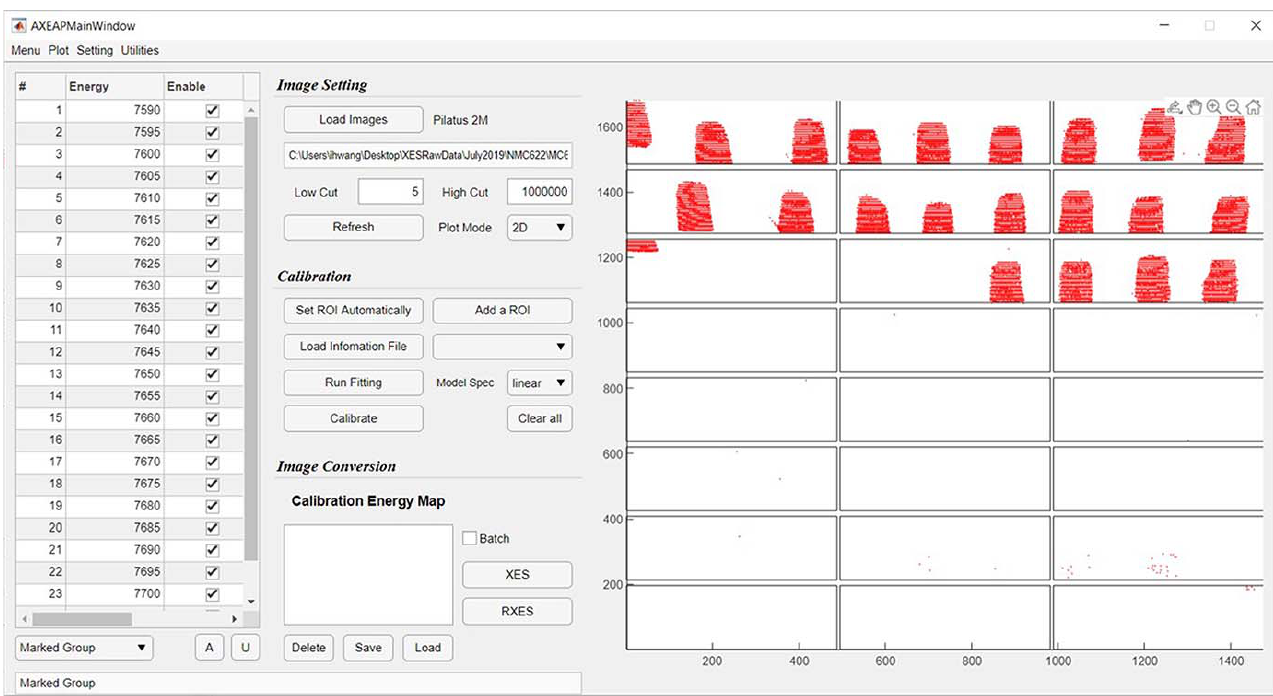
Figure 2 A screenshot of the main window of AXEAP. The graphic part on the right-hand side shows the distribution of the X-ray hit positions as red dots and is divided into 24 areas due to the specification of the detector used for measurement. The signal shown in the graphic part represents the 25 merged images as X-ray hit distributions, which were taken 25 times, each using different incident energies for Co K (cid:2) 1,3 emission line measurements. In this experiment, 22 InP (444) analyzers were